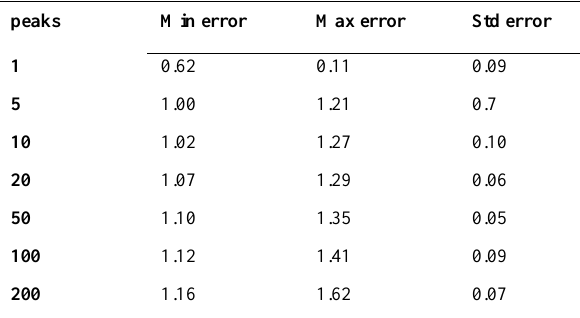
Table 9. Min, Max, and std error for proposed algorithm with frequency change = 5000 and different peaks and different dimensions and shift length =